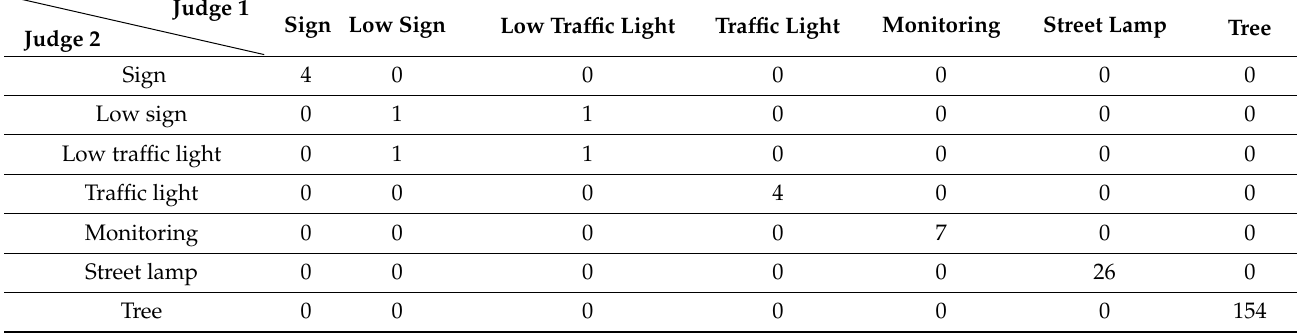
Table A1. This table show the result of Cohen’s kappa coefficient between judge one and judge